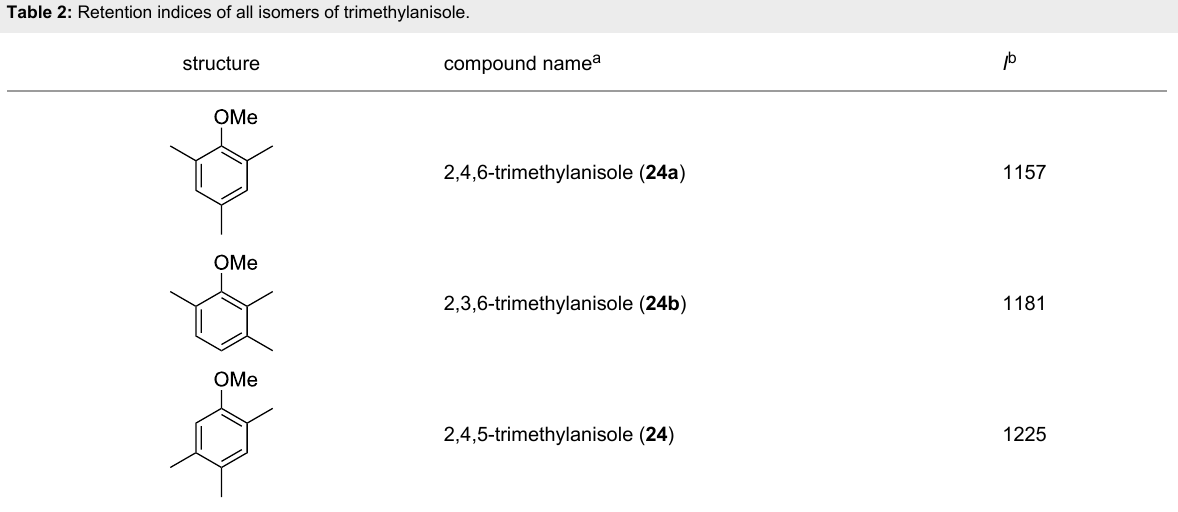
Table 2: Retention indices of all isomers of